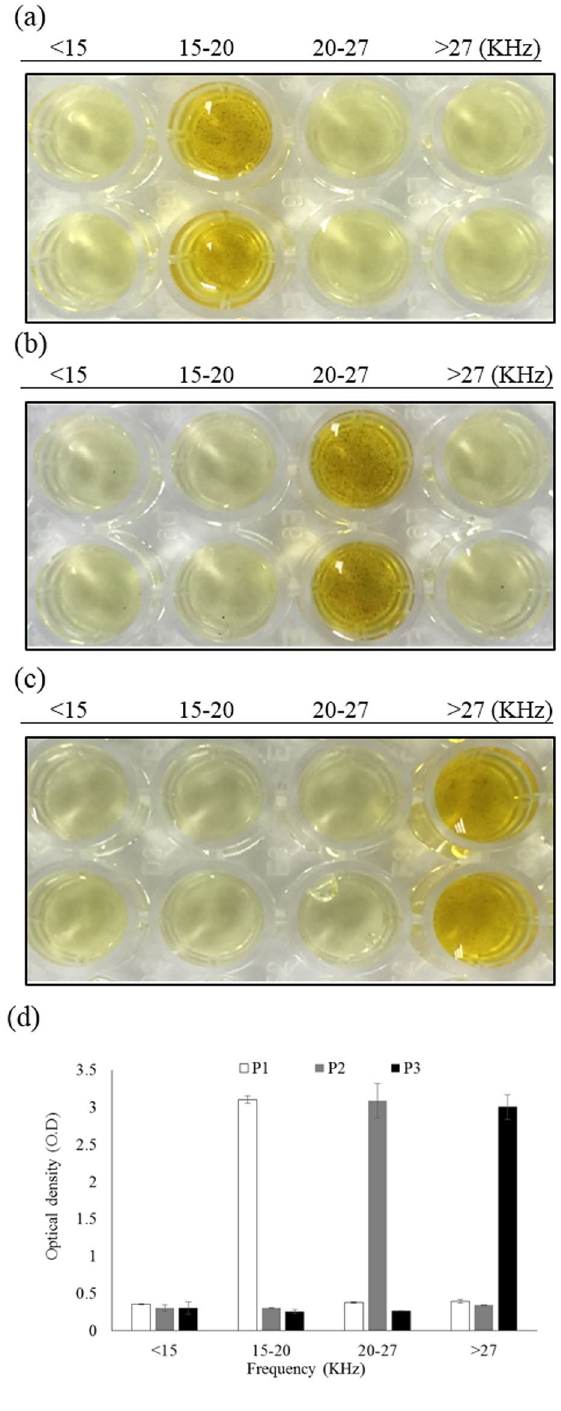
Figure 4. Duplicate photo images (upper and lower rows) for the validation of the MP-1 aptamer capable of conjugating multiple target analytes with different affinities by aptamer-based ELISA, ( a ) CRP (P1), ( b ) HBs Ag (P2), ( c ) HCV NS3 (P3), and ( d ) the measured optical density of control ( < 15 KHz), ( a ), ( b ), and ( c